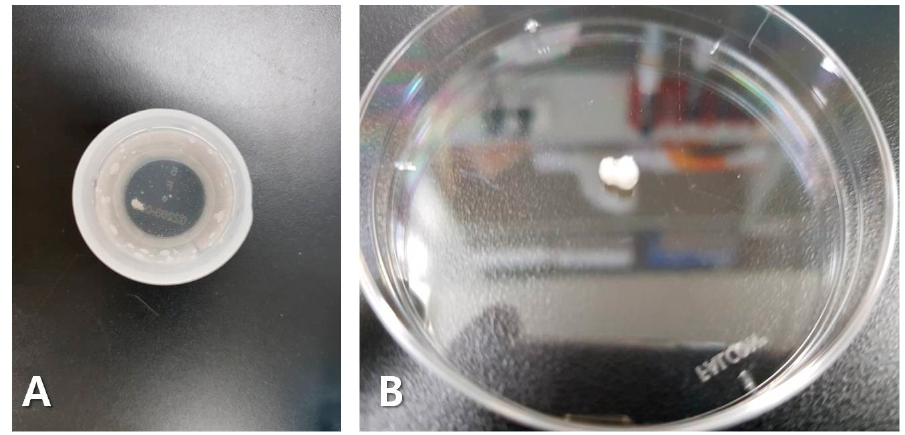
Figure 3. Macroscopically aggregated tissues. As soon as the sample was dipped in the alcohol-based solution, the cells aggregated ( A ), and when one of them was taken out, we could observe hardened aggregated cells ( B ).